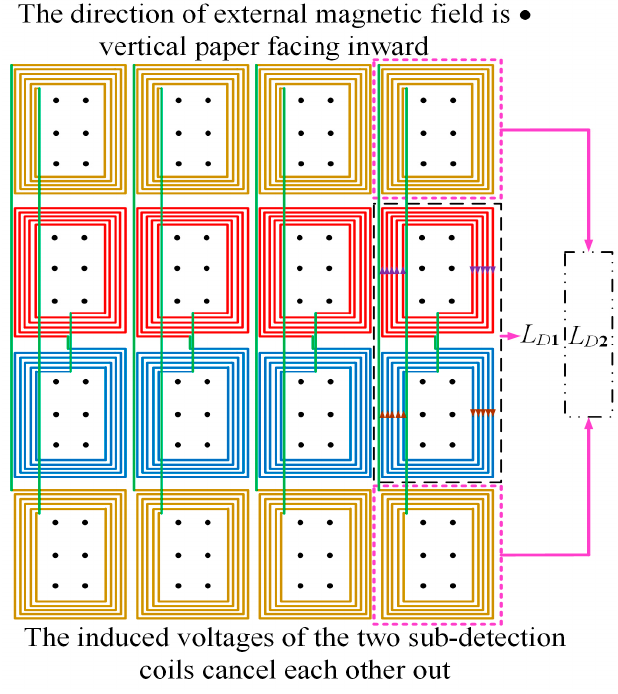
Figure 7. Proposed reverse series structure of detection coil.